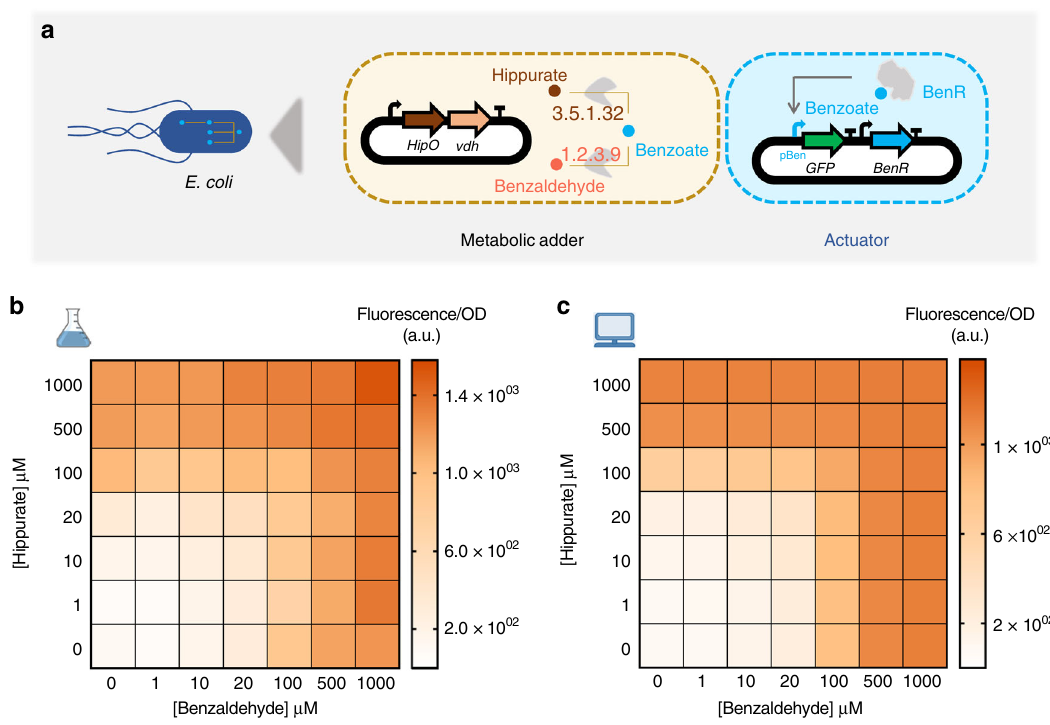
Fig. 2 Whole-cell metabolic adder of hippurate and benzaldehyde. a Hippurate and benzaldehyde transducers are combined to build a metabolic adder producing a common output, benzoate, which is reported through the benzoate actuator. The genes encoding the enzymes are expressed in one operon under control of constitutive promoter J23101 and RBSs B0032 for HipO and B0034 for vdh . b Heatmap representing the output of the adder while increasing the concentration of both inputs, hippurate and benzaldehyde. All data points are the mean of normalized values from measurements taken from three different colonies on the same day. c Model simulations for experimental conditions presented in b . The model was fi tted on transducer data and resource competition data. Source data are provided in the Source Data fi